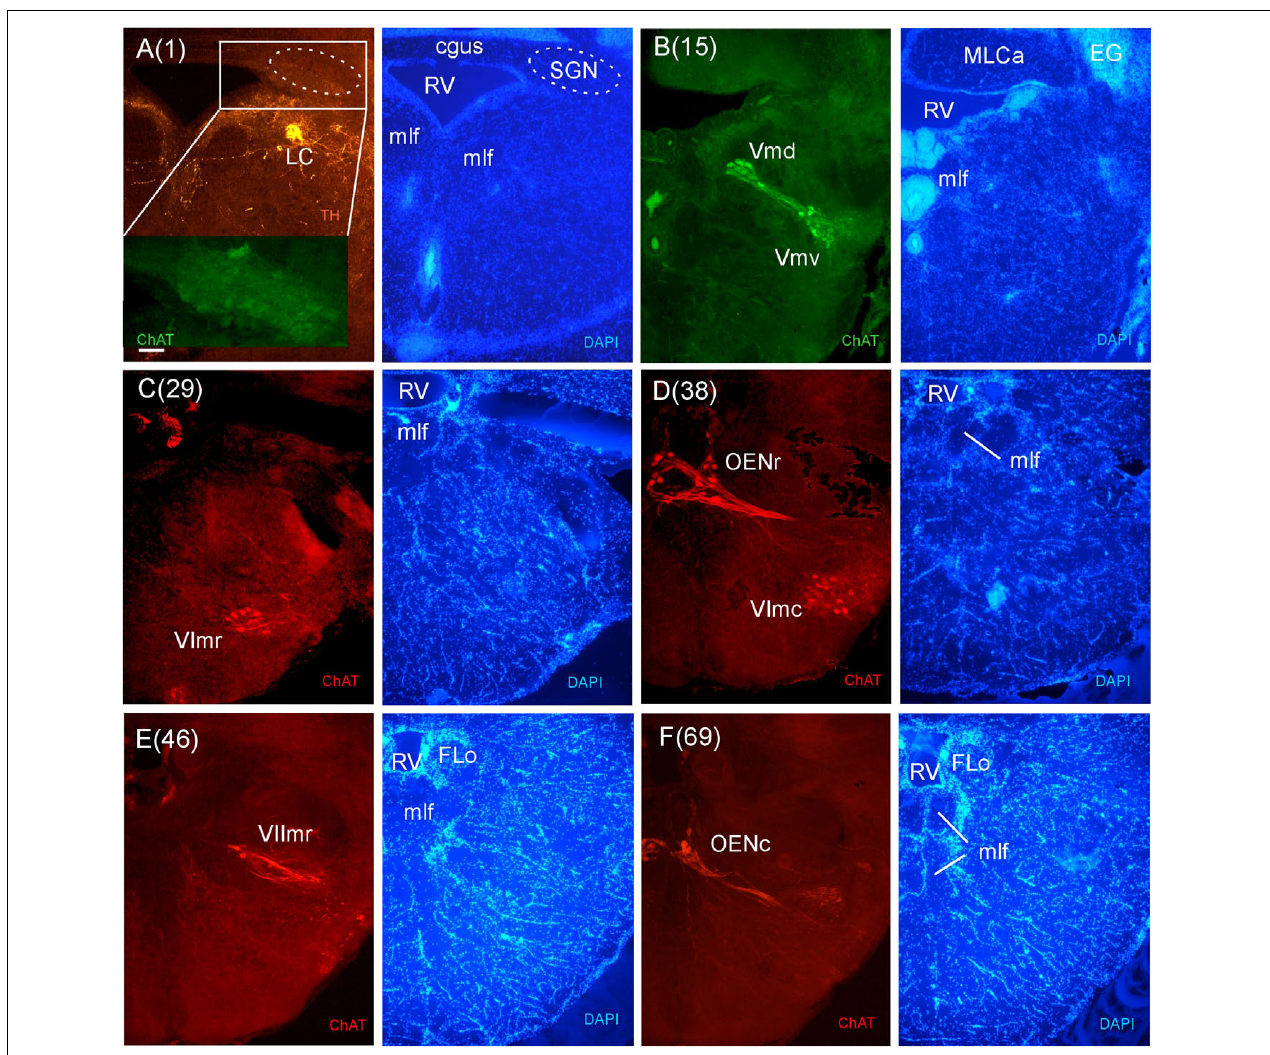
FIGURE 8 | Consecutive transverse sections of the archerfish anterior rhombencephalon double-immunostained for tyrosine hydroxylase (TH) and choline acetyltransferase (ChAT) with accompanying nuclear (DAPI) counterstain. At anterior (isthmic) rhombencephalic levels, the noradrenergic locus coeruleus (LC) is present as is the secondary gustatory nucleus (SGN, seen in the same section in A ). More caudally, the trigeminal (Vmd, Vmv), abducens (VIr, VIc), and rostral facial motor (VIImr) nuclei as well as the octavolateralis cholinergic motor neurons (OENr, OENc) are visualized (B–F) . Arabic numerals in brackets indicate the relative distance of sections. Scale bar in (A) : 0.1 mm (applies to all panels). See abbreviation list and text for